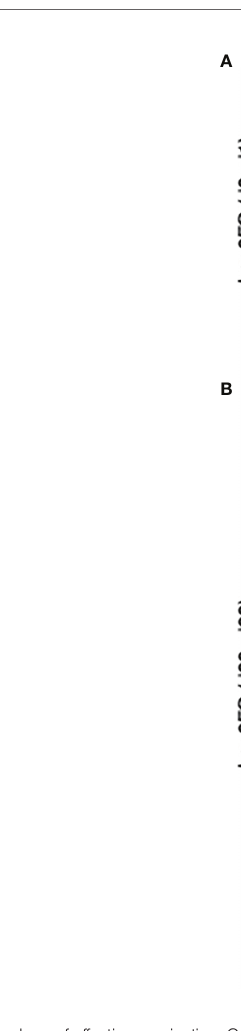
FIGURE 7 | Biomarkers of effective vaccination. Correlations of log2FC after the 1 st vaccination (d2_d1) of (A) IFN- g and IP-10/CXCL10 and levels of anti-Spike Ab measured at d22. Correlations of log2FC after the 2 nd vaccination (d23_d22) of (B) IFN- g , IL-15, IL-7, IL-10 and levels of anti-Spike Ab measured at d50. The analysis was performed on patients in the high/moderate group (n = 25). Spearman r and p values are